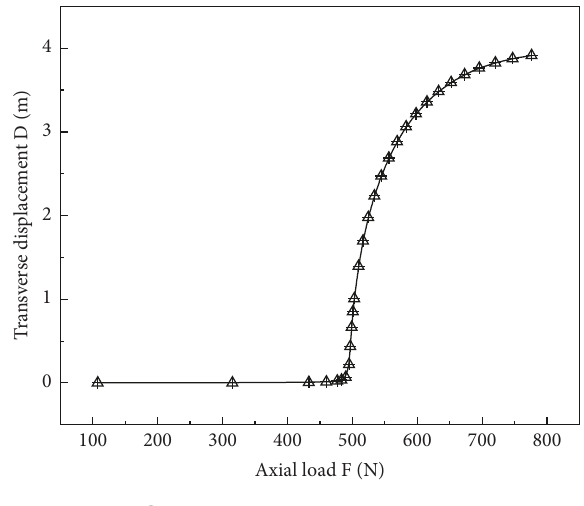
Figure 8: Te transverse displacement-load curve in the middle of mandrel